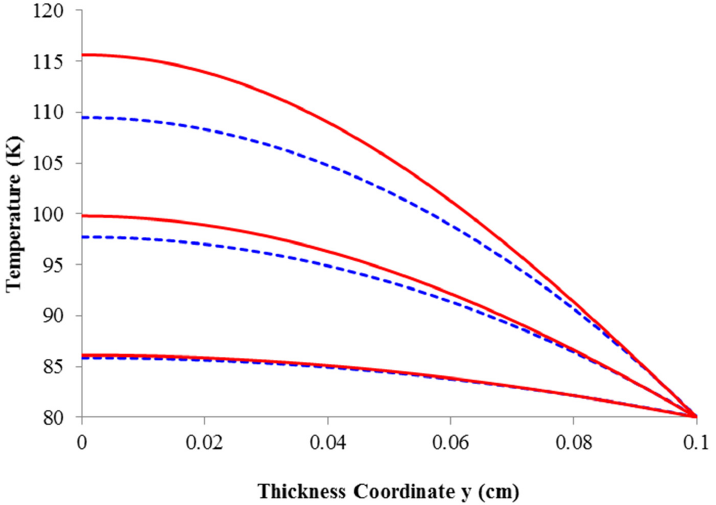
Figure 2. Temperature as a function of thickness coordinate y , for the standard model (blue) and the new model described here, for heat density values of 500, 1500, and 2500 W/cm 3 (bottom to top) and an ambient cooling temperature of 80 K.